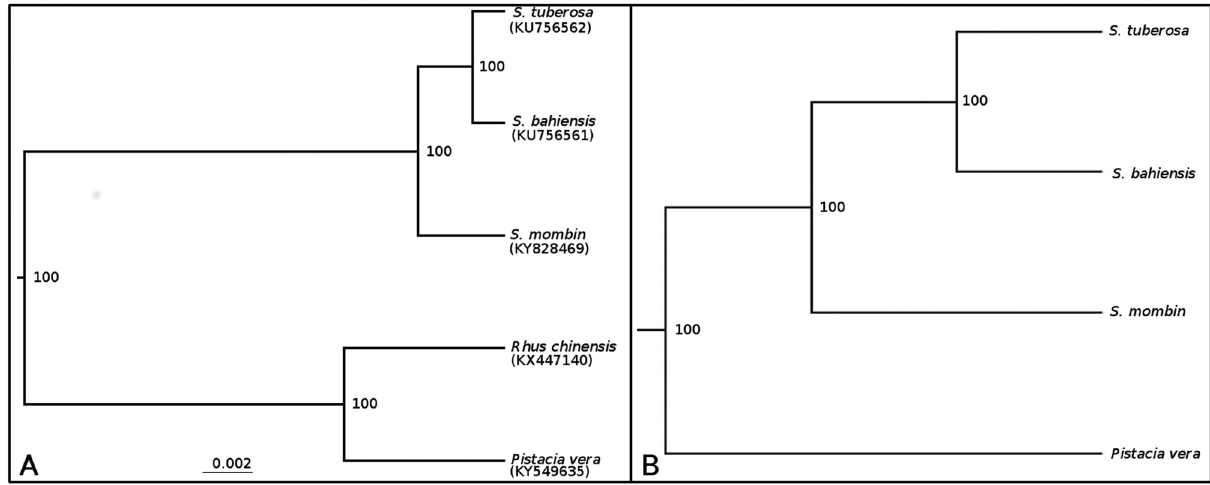
Figure 1 - Phylogenetic analysis of the chloroplast and nuclear genomes. (A) Phylogenetic relationships using the Bayesian approach of the complete chloroplastgenomesofthegenus Spondias andoutgroup Rhuschinenesis and Pistaciavera .Thesupportvaluesareestimatedwithposteriorprobabilities (in percentages). (B) A phylogenetic tree reconstructed with the AAF approach using nuclear reads. The support values are estimated with bootstrap val- ues (in percentages). Table 1 - Number of SNPs present in six contigs for Spondias tuberosa , Spondias bahiensis , and Spondias mombin .